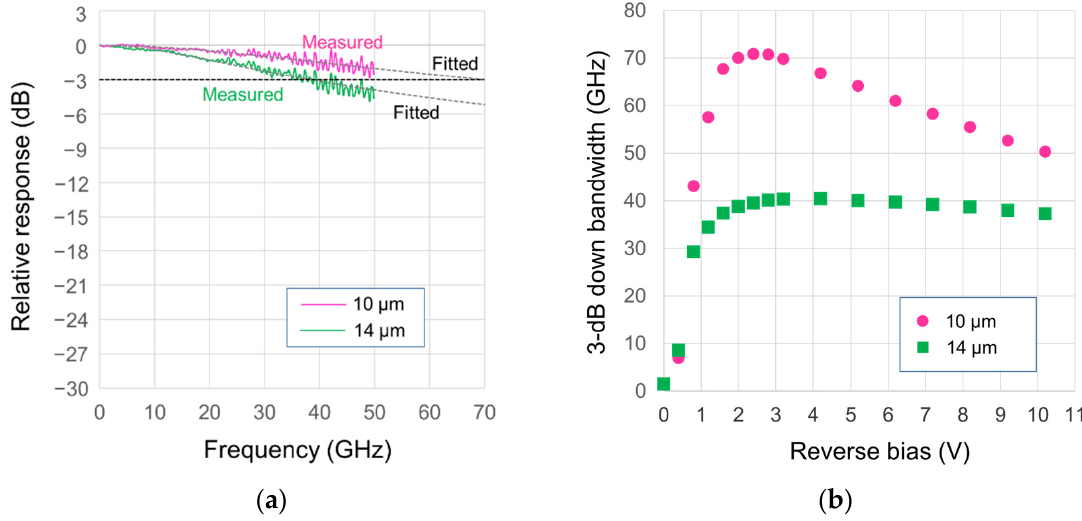
Figure 5. ( a ) Frequency characteristics of our inverted p-down pin photodiodes (pin-PDs) with 10- and 14-um active diameters, and ( b ) the bias-voltage dependence of 3-dB down bandwidth for these pin-PDs.